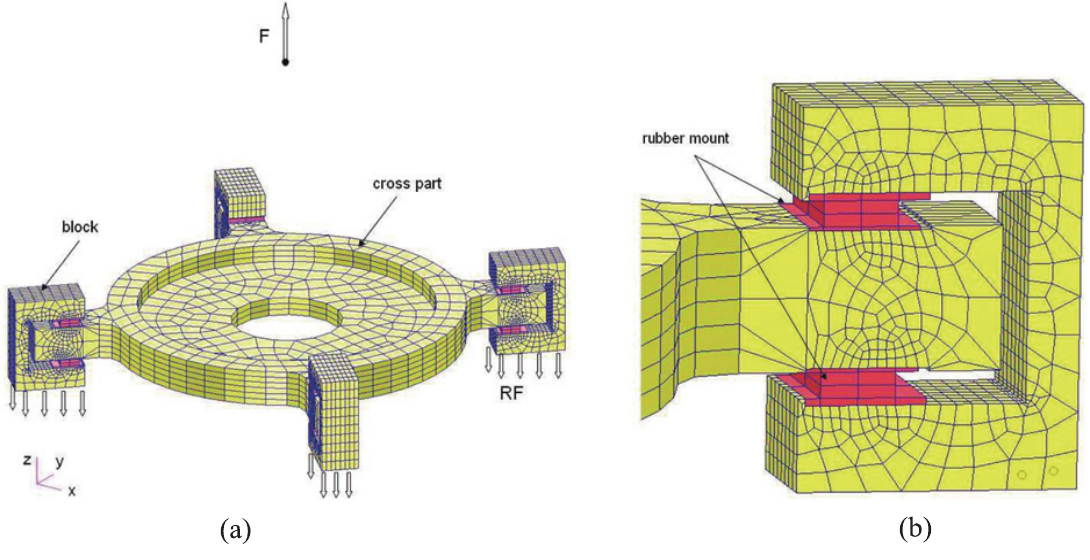
Fig. 3. Elastomeric isolator: (a) Global view, (b) Zoom on one rubber part. Dark colour: